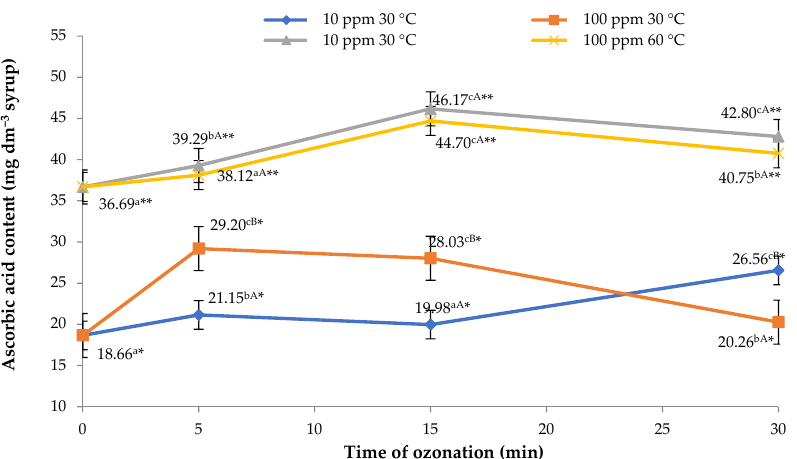
Figure 2. Contents of vitamin C in syrups from flowers of black elder, relative to the dose of ozone applied and temperature of sugar syrup used. Note: Differences in results between the time of ozonation (for certain ozone concentration) are indicated by different small letters, differences between ozone concentration (for certain ozonation time) are indicated by different capital letters and differences between sugar syrup temperatures are indicated by * or ** (for the same ozone-treatment conditions) at α < 0.05.